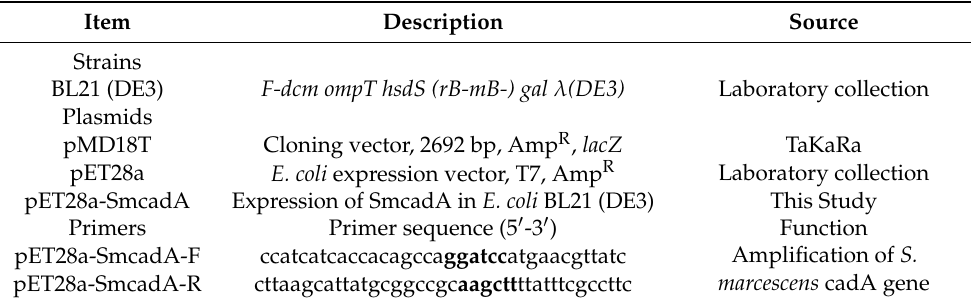
Table 3. Strains, plasmids and primers used in the